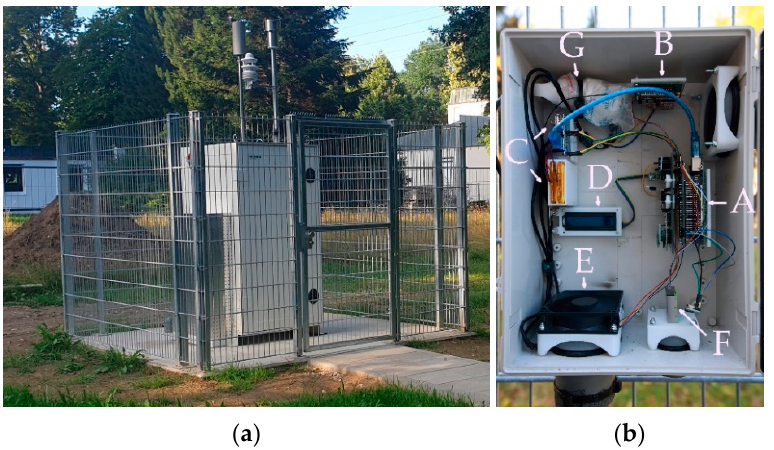
Figure 1. Photographs of the AEMS and an AELCM unit, which is mounted on the fence next to the AEMS: ( a ) the stationary air and climate measurement station of the Chair for Regional Climate Change and Health, Faculty of Medicine, University of Augsburg; and ( b ) the housing of an AELCM unit consists of a weather-proof NEMA (National Electrical Manufacturers Association) enclosure (ABS Plastic Case, PN: NBB-22251; L × W × H: 37 cm × 27 cm × 15 cm). The unit includes a sensor board (equipped with gas sensors and a meteorological sensor) connected to a bus board, which in turn is connected to an Arduino Mega 2560 Rev3 and an external RTC (A). The communication board is equipped with an antenna-equipped Pycom GPy and an SD card module (B). An uninterruptable power supply for the communication device (GPy) and a second one for the measurement system and its external devices (LCD, fan and SD card module) are each connected to a LiPo battery (C). A liquid crystal display (LCD) shows the status and functionality of the AELCM unit (D). The DC PWM fan inside the enclosure (ODROID-H2 DC Fan; L × H × D: 92 mm × 92 mm × 25 mm) makes use of the custom air inlet (top right) and custom air outlet (bottom left) for the exchange of air (E). The SPS30 located at the bottom of the box directly coupled to the ambient air through a short plastic pipe (F). Both uninterruptable power supplies are connected to a two-port USB charger plugged into a regular power socket (G). Table 1. Overview of the specifications of the sensors that can be used in the AELCM unit.